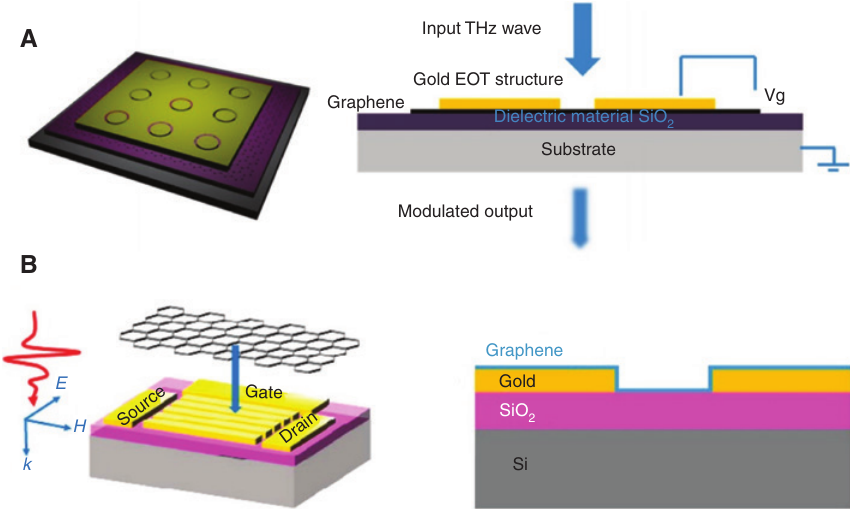
Figure 29: Graphene-integrated plasmonic metal structures for THz modulation, utilizing tunability of graphene and strong local field enhancement.